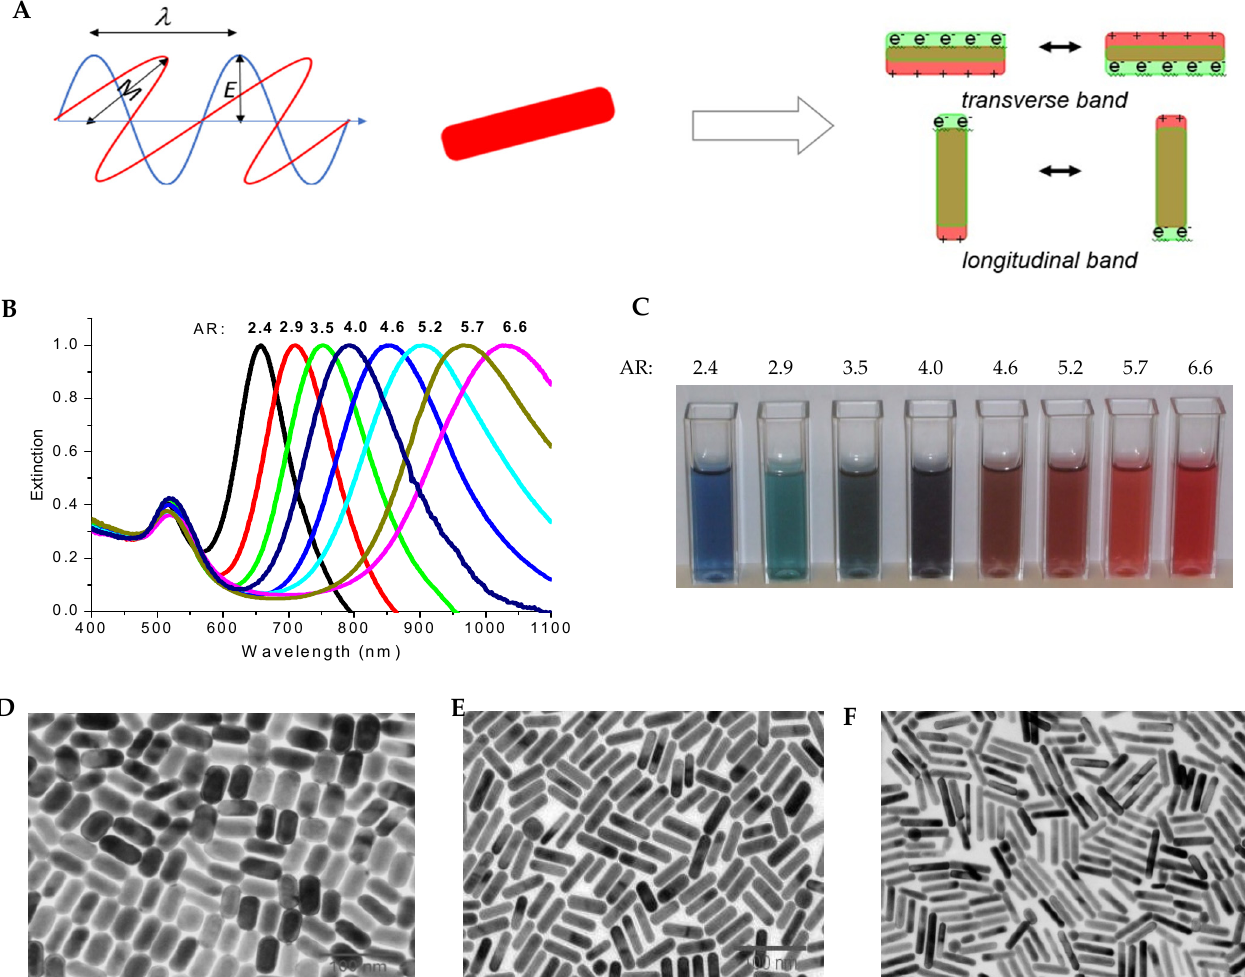
Figure 1. Optical Properties of AuNRs. ( A ) Schematic of the coherent and collective electron oscillations along the long and short axes of AuNRs resulting in longitudinal and transverse LSPR bands, respectively. Blue line is electric field and red line is magnetic field. ( B ) Dependence of LSPR of AuNRs on the aspect ratio (AR). Increasing AR leads to red shift of the longitudinal LSPR. ( C ) Photographic picture of the solution of AuNRs with different ARs. ( D – F ) TEM images of AuNRs with aspect ratio of 2.9 ( C ), 4.0 ( D ), and 4.6 ( E ).